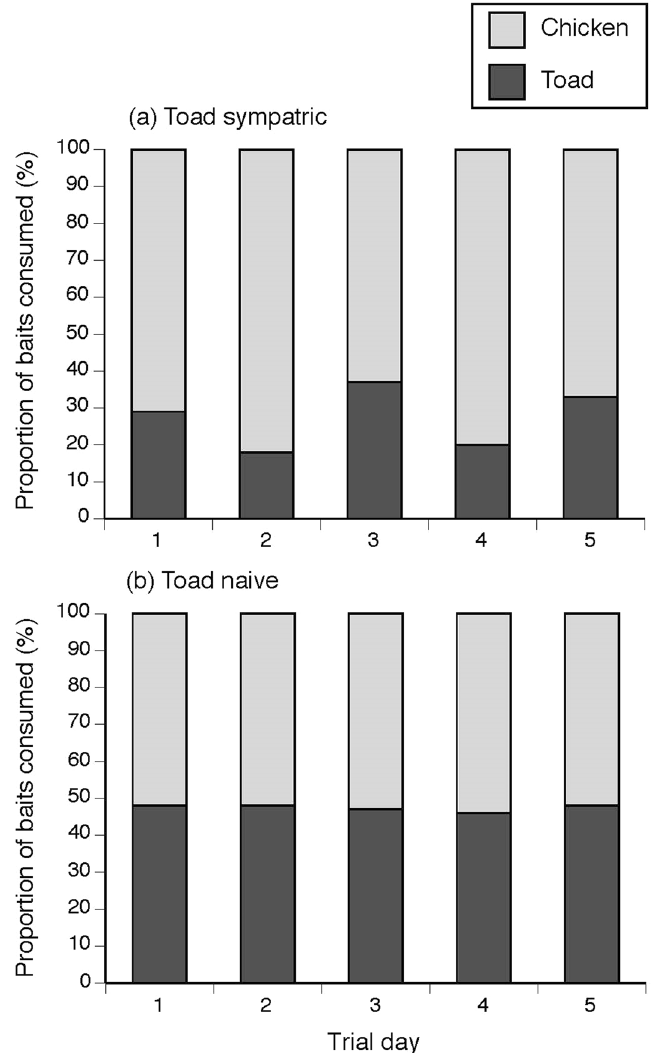
Figure 2. Proportion of chicken versus cane toad baits eaten by freshwater crocodiles ( Crocodylus johnstoni) over the trial period by ( a ) crocodiles from toad-sympatric populations and ( b ) crocodiles from toad-naïve